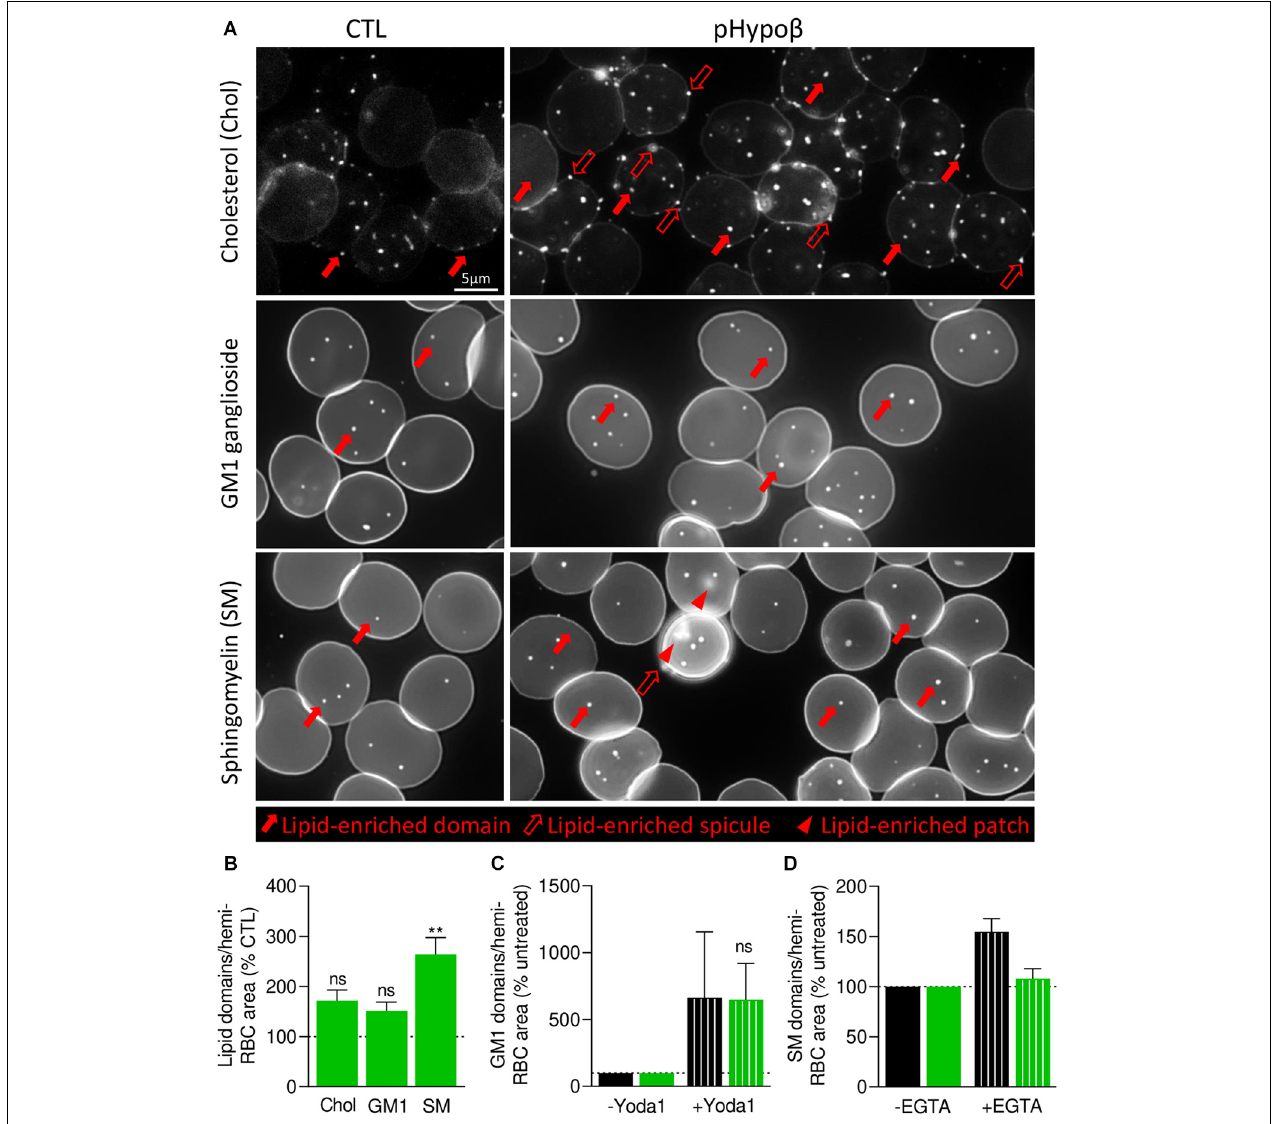
FIGURE 8 | In contrast to cholesterol- and GM1-enriched domains, those enriched in sphingomyelin are modified in abundance and functionality at the pHypo β RBC surface. RBCs from healthy donors (CTL, black columns) or pHypo β (green columns) were either left untreated (not-hatched columns) or incubated with Yoda1 for 30 s (hatched columns in C ) or EGTA for 10 min in a calcium-free medium (hatched columns in D ). All RBCs were then either labeled with the fluorescent Theta toxin fragment specific to endogenous cholesterol and then immobilized on PLL-coated coverslips (Chol; A,B ); or immobilized on PLL-coated coverslips and then labeled with fluorescent BODIPY analogs of GM1 ganglioside (GM1; A–C ) or sphingomyelin (SM; A,B,D ). All coverslips were then directly observed by vital fluorescence microscopy. (A) Representative images of Chol-, GM1-, and SM-enriched domains, spicules or patches in untreated RBCs. Large filled arrows, lipid-enriched domains; large open arrows, lipid-enriched spicules; arrowheads, lipid-enriched patches. (B–D) Quantification of lipid domain abundance in RBCs either untreated or treated with Yoda1 or EGTA to, respectively, activate PIEZO1 (C) or induce intracellular calcium depletion (D) . In (D) the calcium-free medium containing EGTA is maintained all along the experiment. Data are normalized to the hemi-RBC area and are means ± SEM of 4–5 independent experiments (B) or means ± SD/SEM of 2–3 independent experiments (C,D) . Kruskal–Wallis test followed by Dunn’s comparison test (B) and Wilcoxon matched-pairs signed rank tests (C) . ns, not significant; ** p <